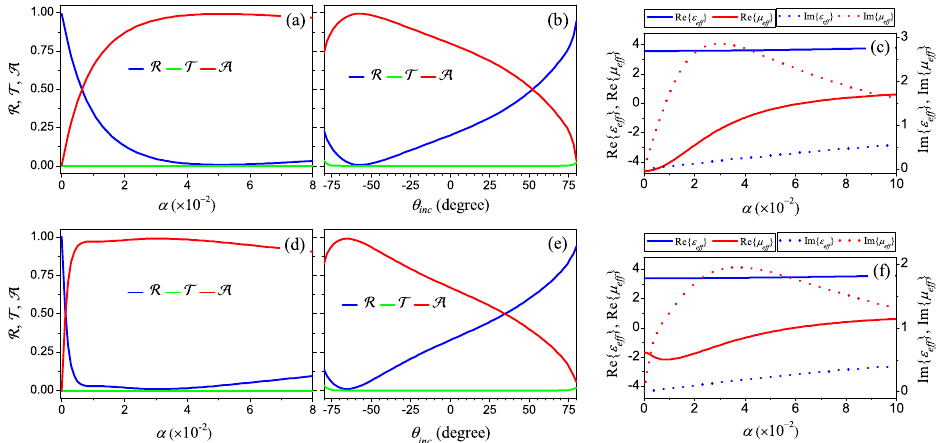
Figure 3. R , T , and A are plotted as the functions of damping factor α ( a ), ( d ) at a fixed incident angle θ inc = 55 ◦ and also plotted as the functions of the incident angle θ inc ( b ), ( e ) with a fixed damping factor 5 × 10 − 2 for the MM slab of type I ( a , b ) and type II ( d , e ). The effective permittivity ε ef f and effective permeability µ ef f are plotted as the functions of the damping factor α for the MM slab of type I ( c ) and type II ( f ). The bias magnetic field is H 0 = 600 Oe and the working frequency is f = 4 GHz and the other parameters are the same as those in Figure